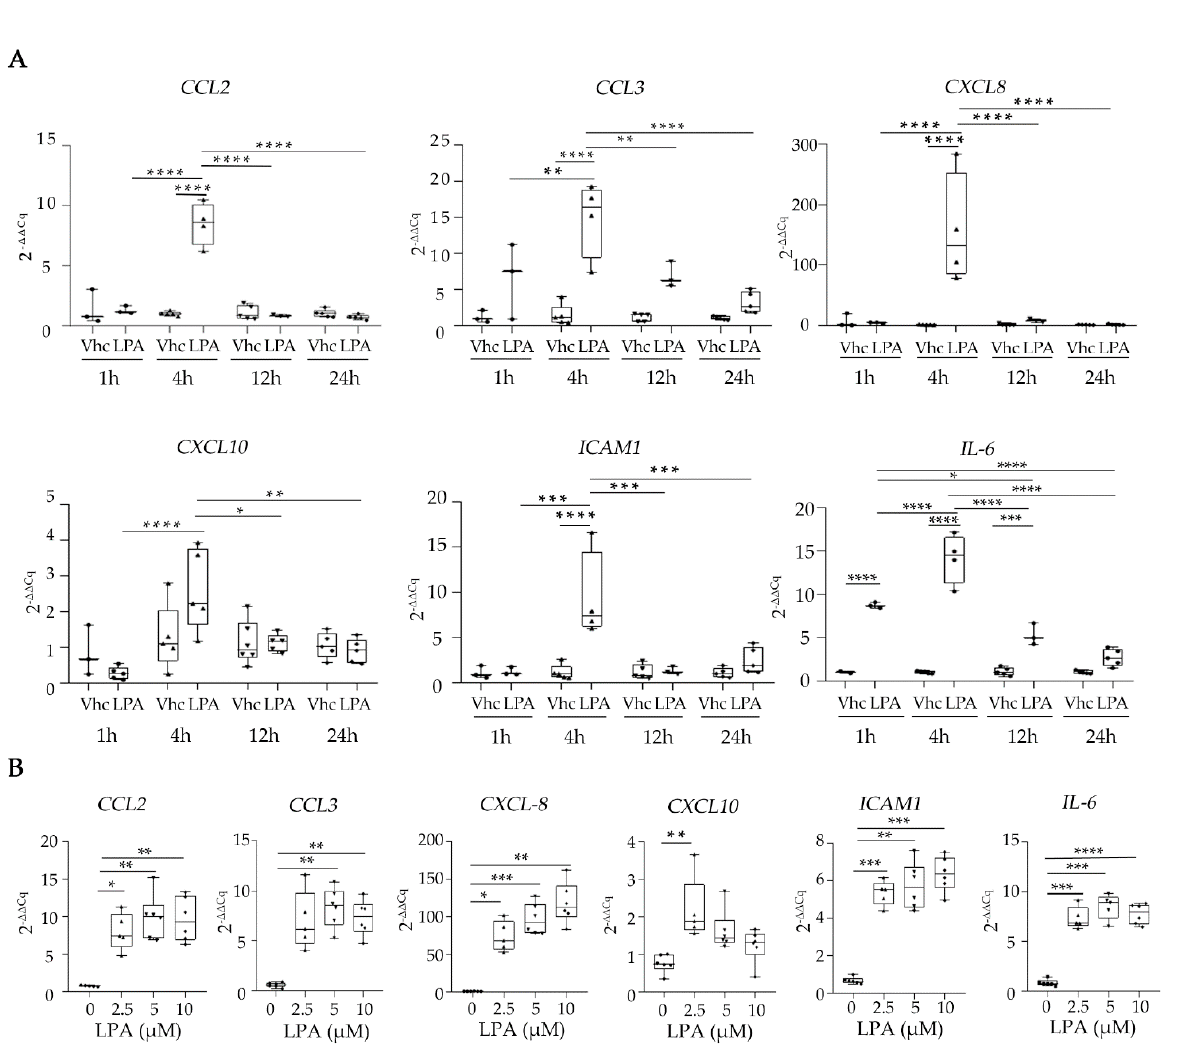
Figure 7. LPA stimulates the expression of CCL2, CCL3, CXCL8, CXCL10, ICAM1 , and IL6 from human kidney proximal tubular epithelial cells (HKC-8). ( A , B ) HKC-8 cells were incubated for 1, 4, 12, and 24 h with 10 µ M of LPA ( A ), and with 2.5, 5, and 10 µ M LPA for 4 h ( B ). Control cells were stimulated with the equivalent volume of chloroform (VHC). mRNA-expression levels of the indicated secreted factors were quantified with RT-qPCR. The Cq values of each gene were normalized against the Cq values of B2M . The results represent the findings of two ( A ) and three ( B ) separate experiments. In ( A ) circles, upward triangles, downward triangles and diamonds refer to 1, 4, 12 and 24 hours of incubation with LPA, respectively. In ( B ) circles, upward triangles, downward triangles and diamonds refer to incubation with 0, 2.5, 5 and 10 µ M LPA, respectively. Statistical significance was assessed in ( A ) with 2-way ANOVA and Tukey’s post hoc test and in ( B ) with Brown-Forsythe’s and Welch’s test or the Kruskal–Wallis test depending on the normality status of the data; * p < 0.05, ** p < 0.01, *** p < 0.001, **** p < 0.0001. See also Figure